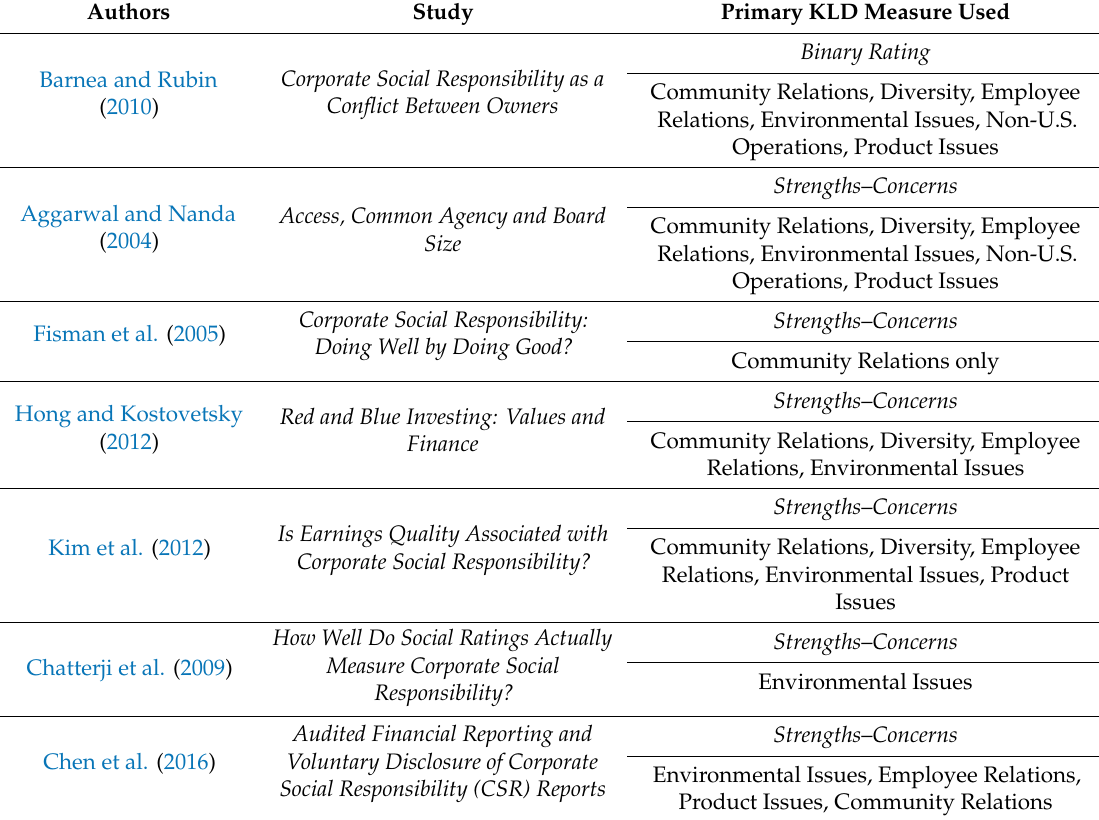
Table 1. Comparison of CSR Measures Using KLD Data. This table presents a summary of the KLD data used to create the primary Corporate Social Responsibility variable in a sample of recent, significant studies on CSR. This is not meant to be an exhaustive list, by any means. As each study has a di ff erent purpose and perspective, each study has created a unique CSR variable using the KLD